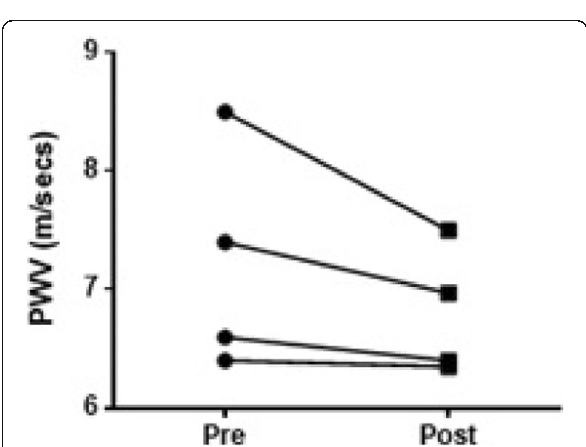
Fig. 2 (abstract P161). Effect of exercise training (pre and post 12- weeks) in